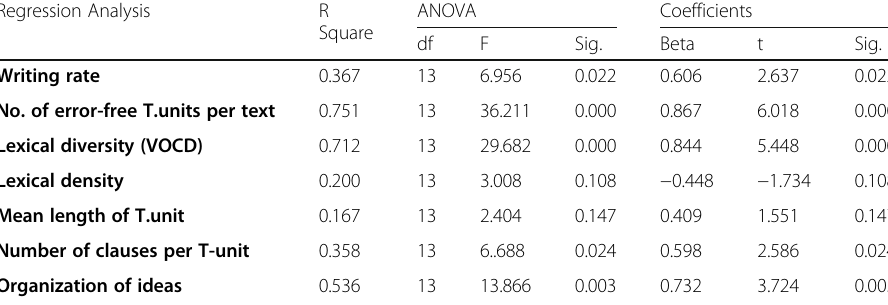
Table 6 Regression analysis for the engagement rate with the suggested YouTube channel Regression Analysis